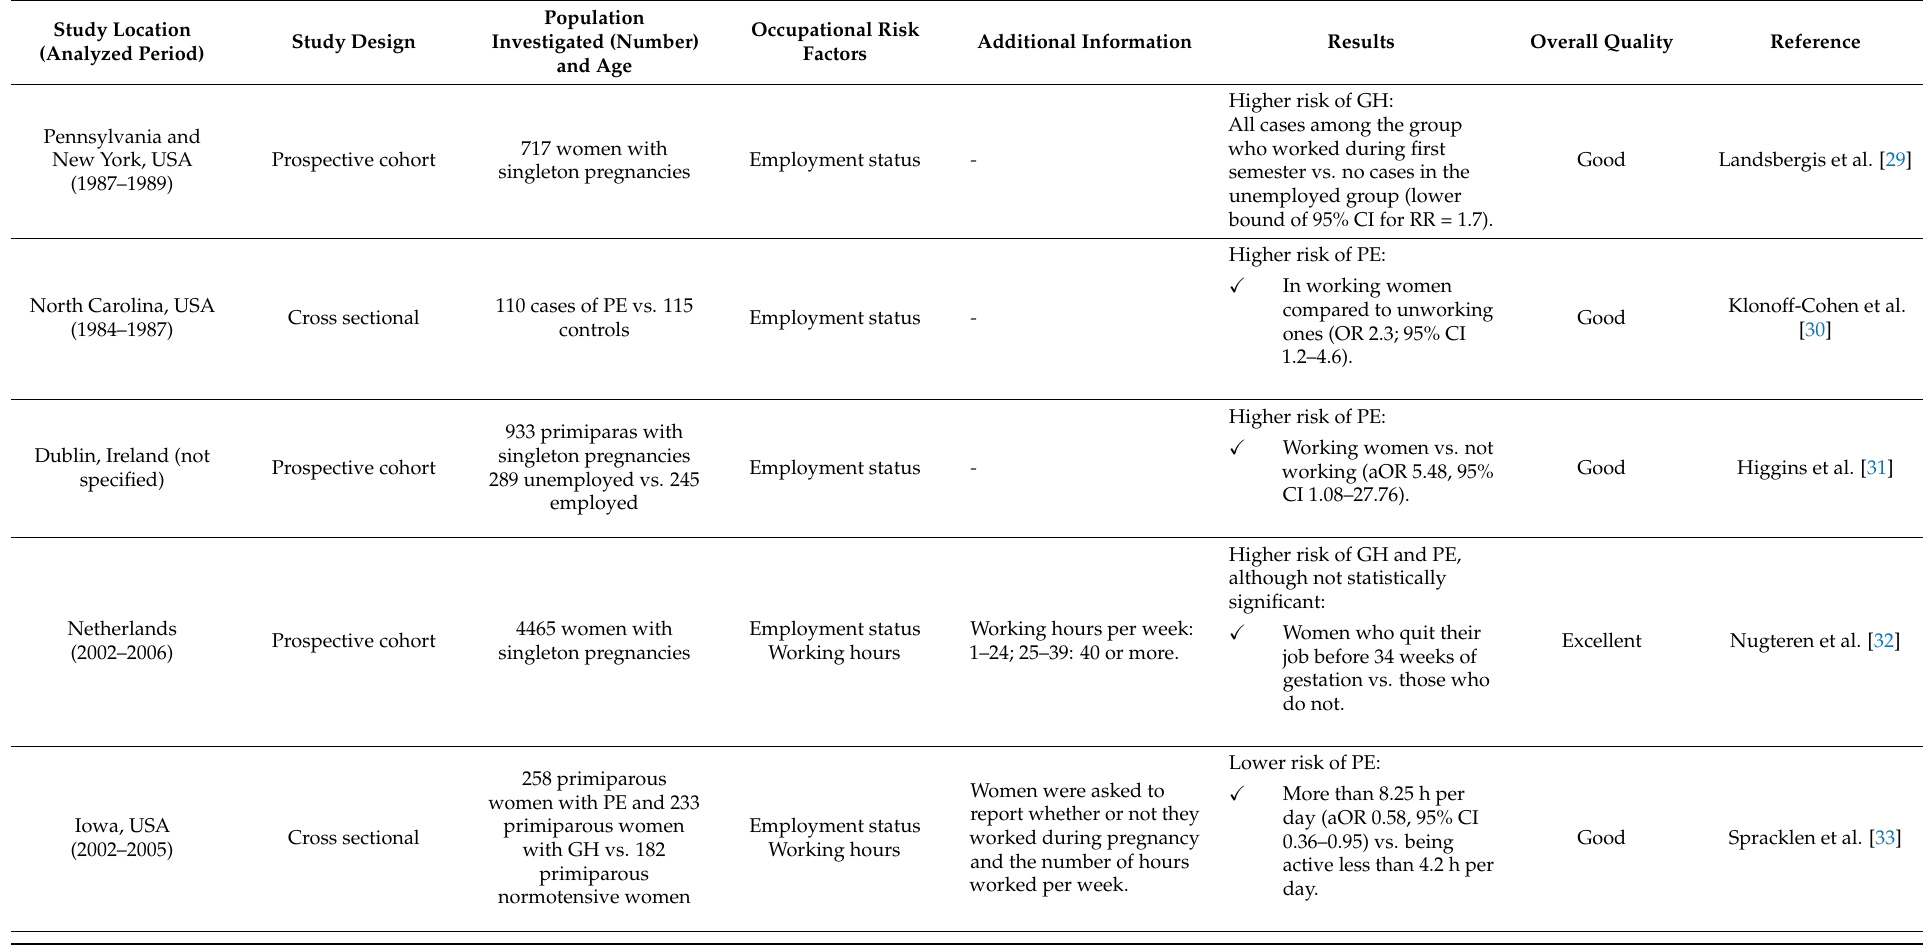
Table 1. Studies assessing the relationship between hypertensive disorders in pregnancy (HDP), including preeclampsia (PE) and pregnancy induced hypertension (GH), and employment